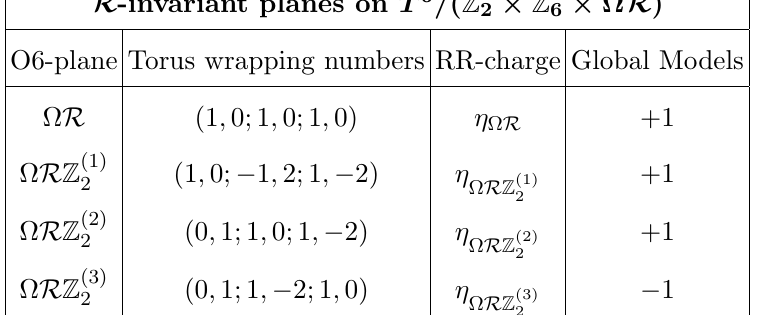
Table 2 . O6-planes on the aAA lattice of T 6 = ( Z 2 (cid:2) Z 6 (cid:2) (cid:10) R ) with discrete torsion ( (cid:17) = (cid:0) 1). The last column indicates the regular/exotic sign of the RR-charges for the global models discussed in sections 3 and 4.